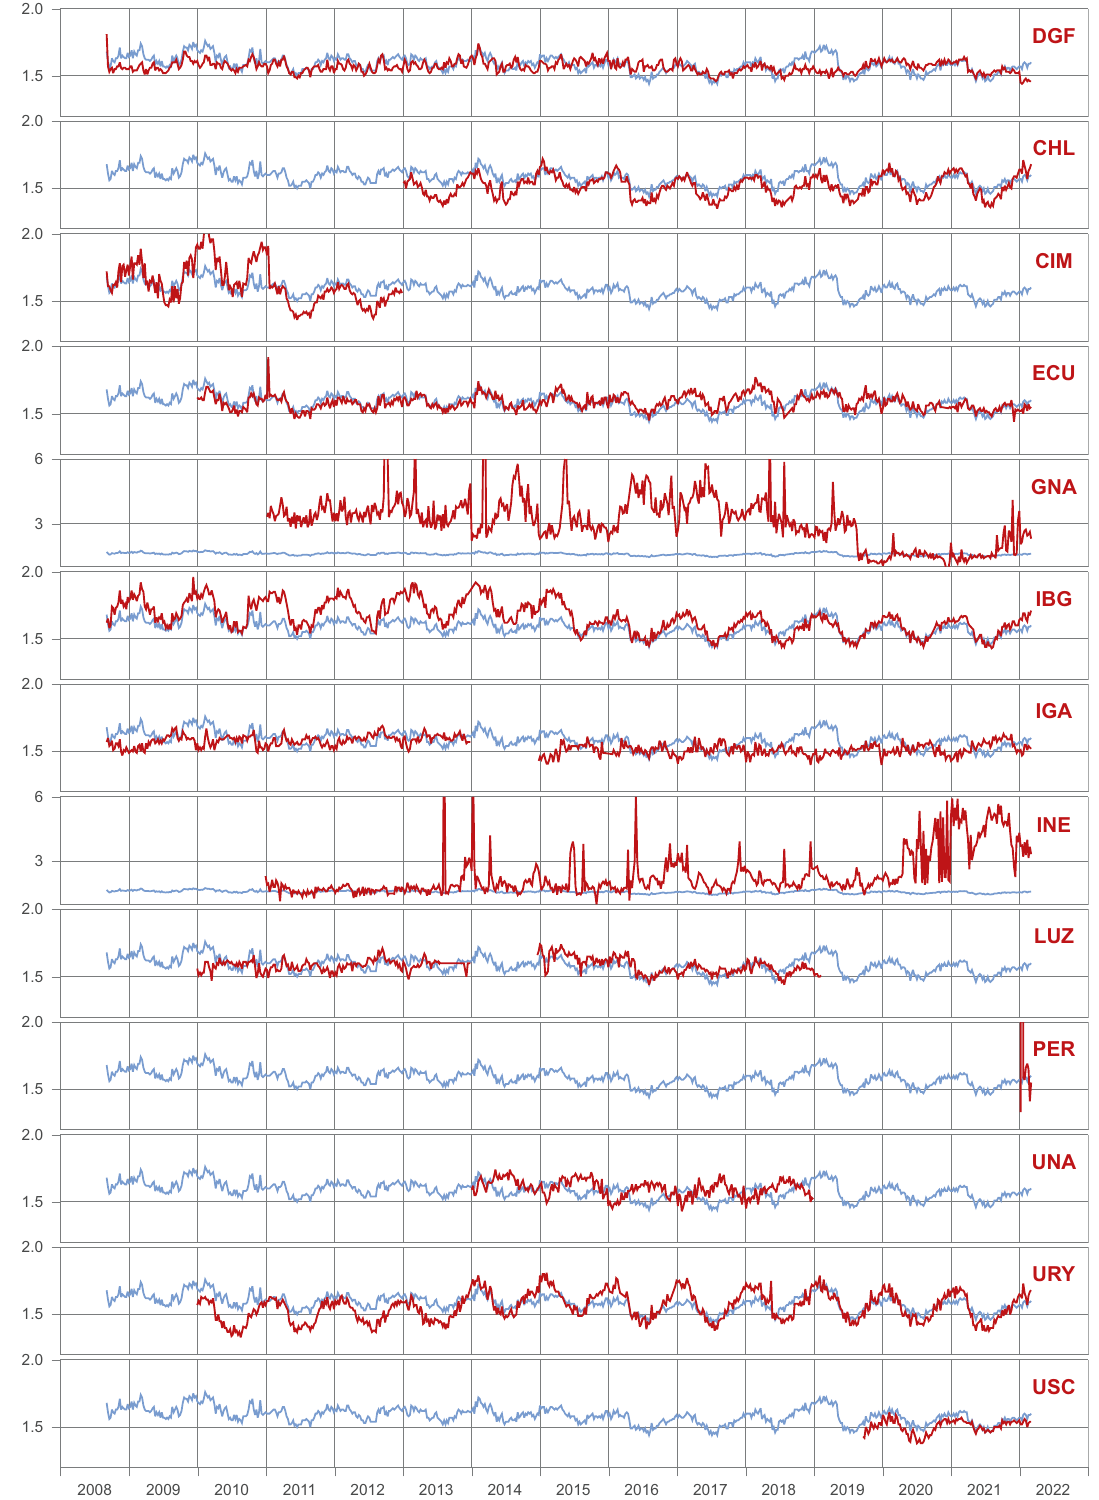
Figure 6: A posteriori variance values in mm after solving the individual station position solutions with respect to the IGS reference frame. These values represent the formal errors of the individual solutions. For comparison, the blue line in the plots represents the variance of the SIRGAS weekly combined